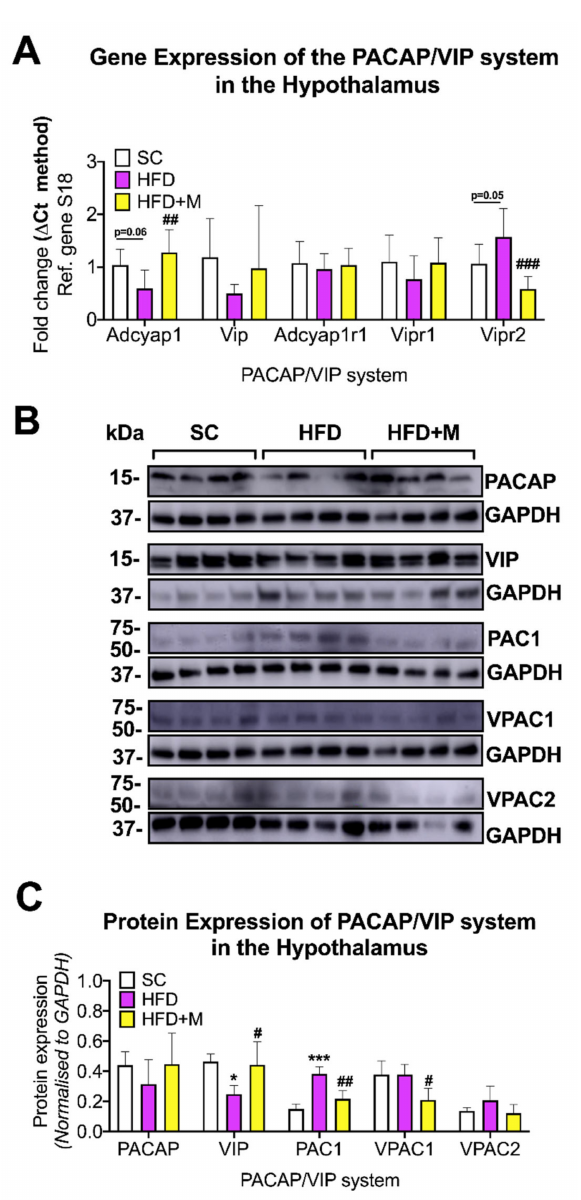
Figure 7. Gene and protein expression analysis of the PACAP/VIP system in the hypothalamus of C57BL/6 mice in response to HFD or metformin administration. Mice were grouped as SC, HFD, and HFD + M. Hypothalami were microdissected from the left and right sides of the brain from all treatment groups and were used for RNA and protein extraction with subsequent quantitative qPCR and Western blotting, respectively. ( A ) Differential gene expression levels of the PACAP/VIP system, ( B ) Immunoblot bands for PACAP/VIP system members were represented. ( C ) Protein expression levels of the PACAP/VIP system following normalization to the loading control, GAPDH. mRNA levels were quantified using the ∆ Ct method and normalized to the reference gene S18 (housekeeping gene). Data were given as mean ± S.E.M. ## p < 0.01 or ### p < 0.001 vs. HFD group as determined by One-Way ANOVA followed by Tukey post-hoc test. n = 6–8 per group. Quantification of immunoblot bands was performed using the NIH ImageJ software. Data were given as mean ± S.E.M. * p < 0.05